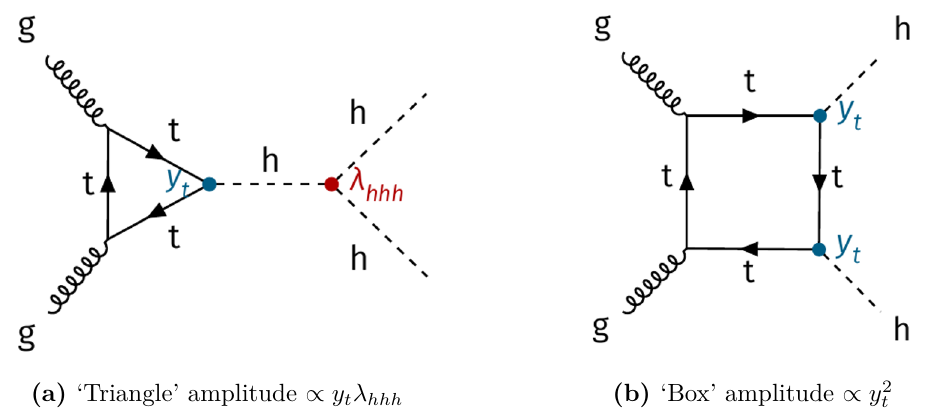
Figure 1. Leading order Feynman diagrams of Higgs boson pair production in gluon fusion. The (a) ‘triangle’ amplitude features the trilinear self-coupling λ hhh and one power of the top Yukawa y t , and (b) ‘box’ amplitude does not feature λ hhh and has two powers of y t . These two diagrams interfere destructively in the